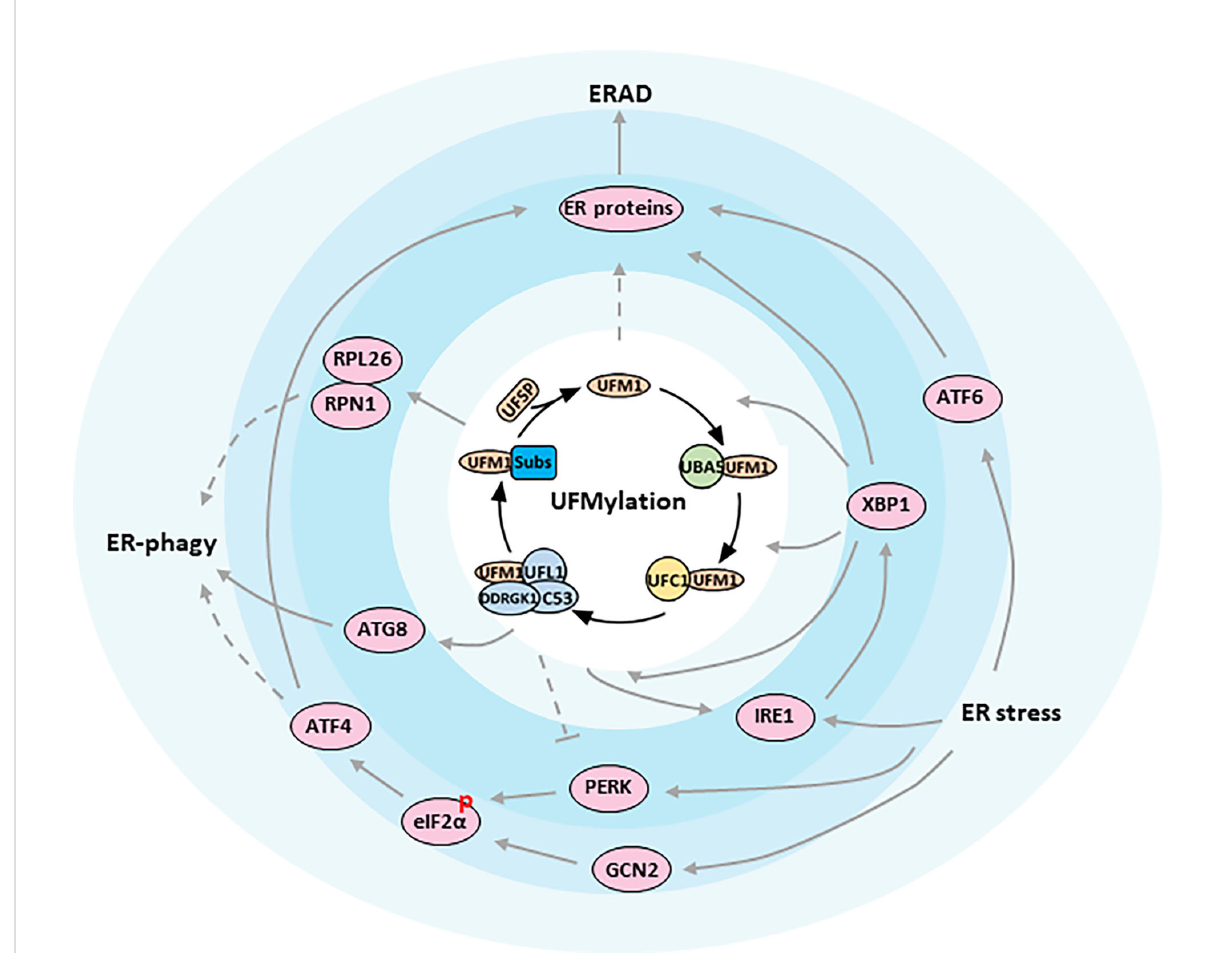
FIGURE 1 ER proteostasis mechanisms of UFMylation. Functional relationships between components are indicated. The fi gure presents key components of the UFMylation pathway in the center of the regulatory network. Arrows indicate activation whereas bar-ended lines indicate inhibitory interactions. Broken lines indicate indirect interactions or interactions requiring further